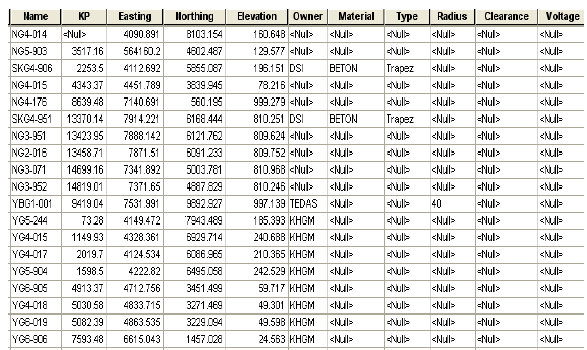
Figure5. Pipeline Obstacle List Sample